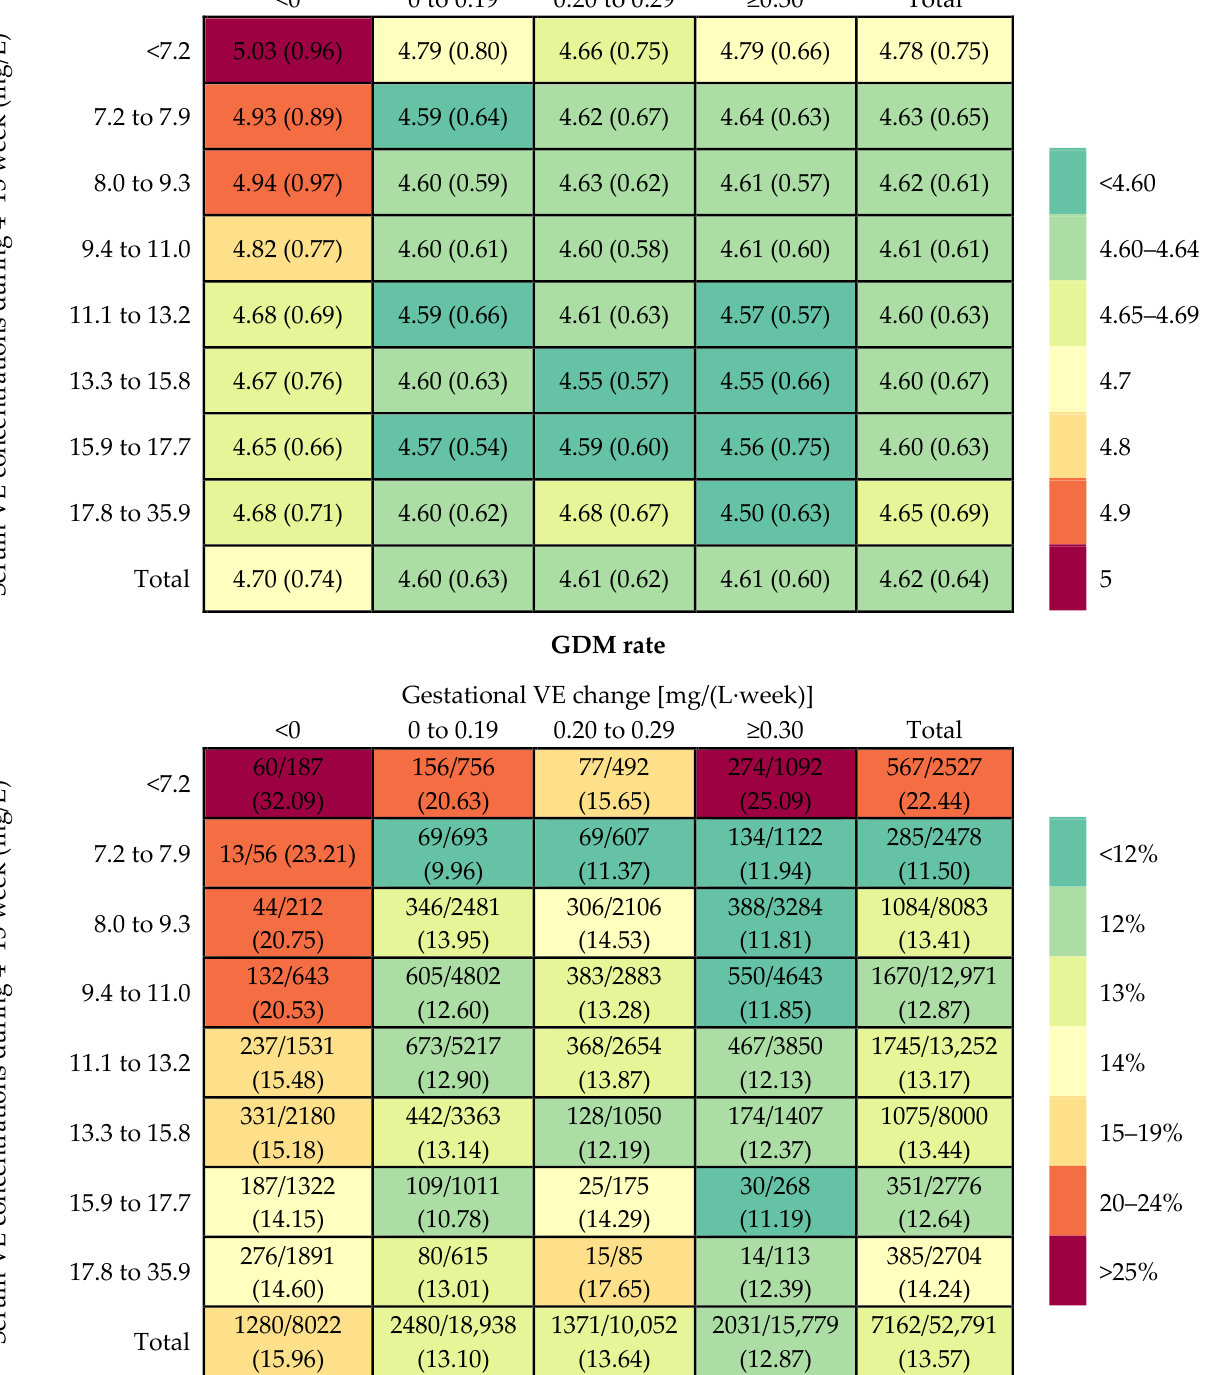
Figure 1. Rate of GDM and concentration of FPG within each combination of the first-trimester vitamin E (VE) concentration categories and gestational VE change categories.